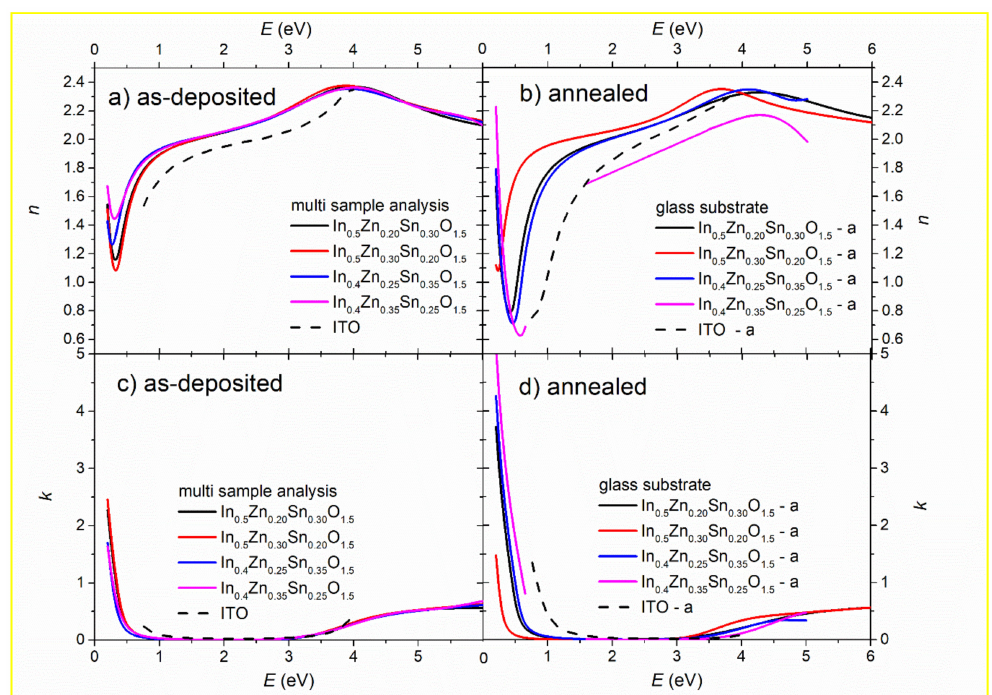
Figure 2. Spectral dependence of refractive index, n , and extinction coefficient, k , determined from spectroscopic ellipsometry for as-deposited (data from samples onto glass substrate and onto SiO 2 /Si substrate were fitted simultaneously) and annealed non-stoichiometric IZTO samples. Optical constants of indium tin oxide (ITO) [7] are added for comparison.